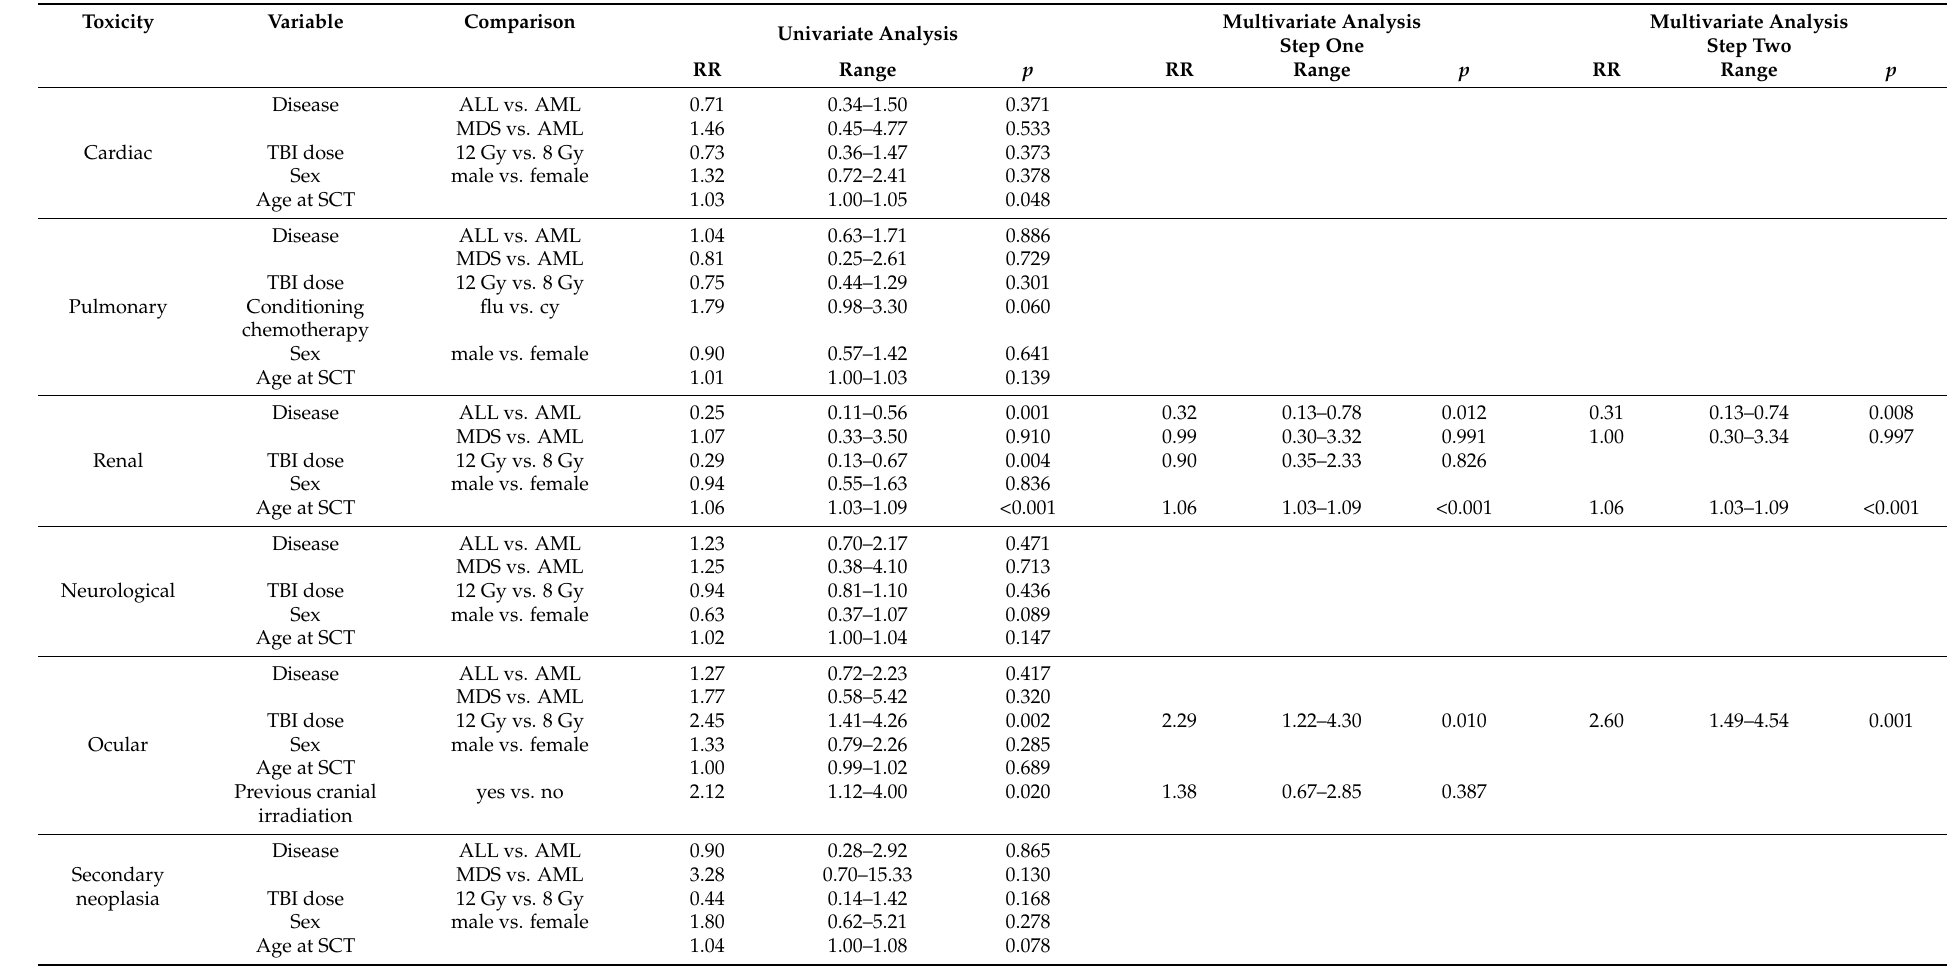
Table 3. Univariate and multivariate analysis of different risk factors for organ-specific